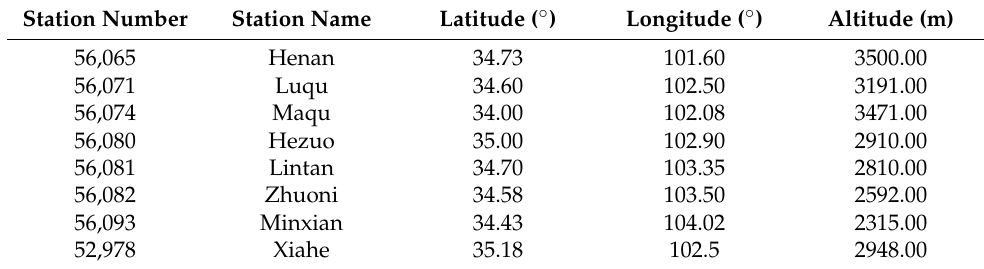
Table 1. Information from main meteorological stations in upper Taohe River Basin.